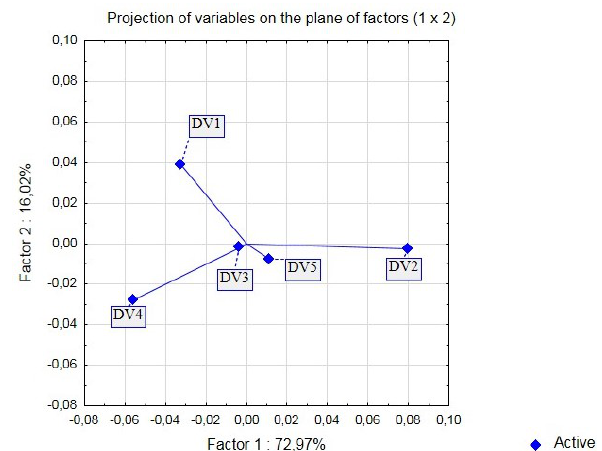
Figure 6: Chart 2W factors for criteria.